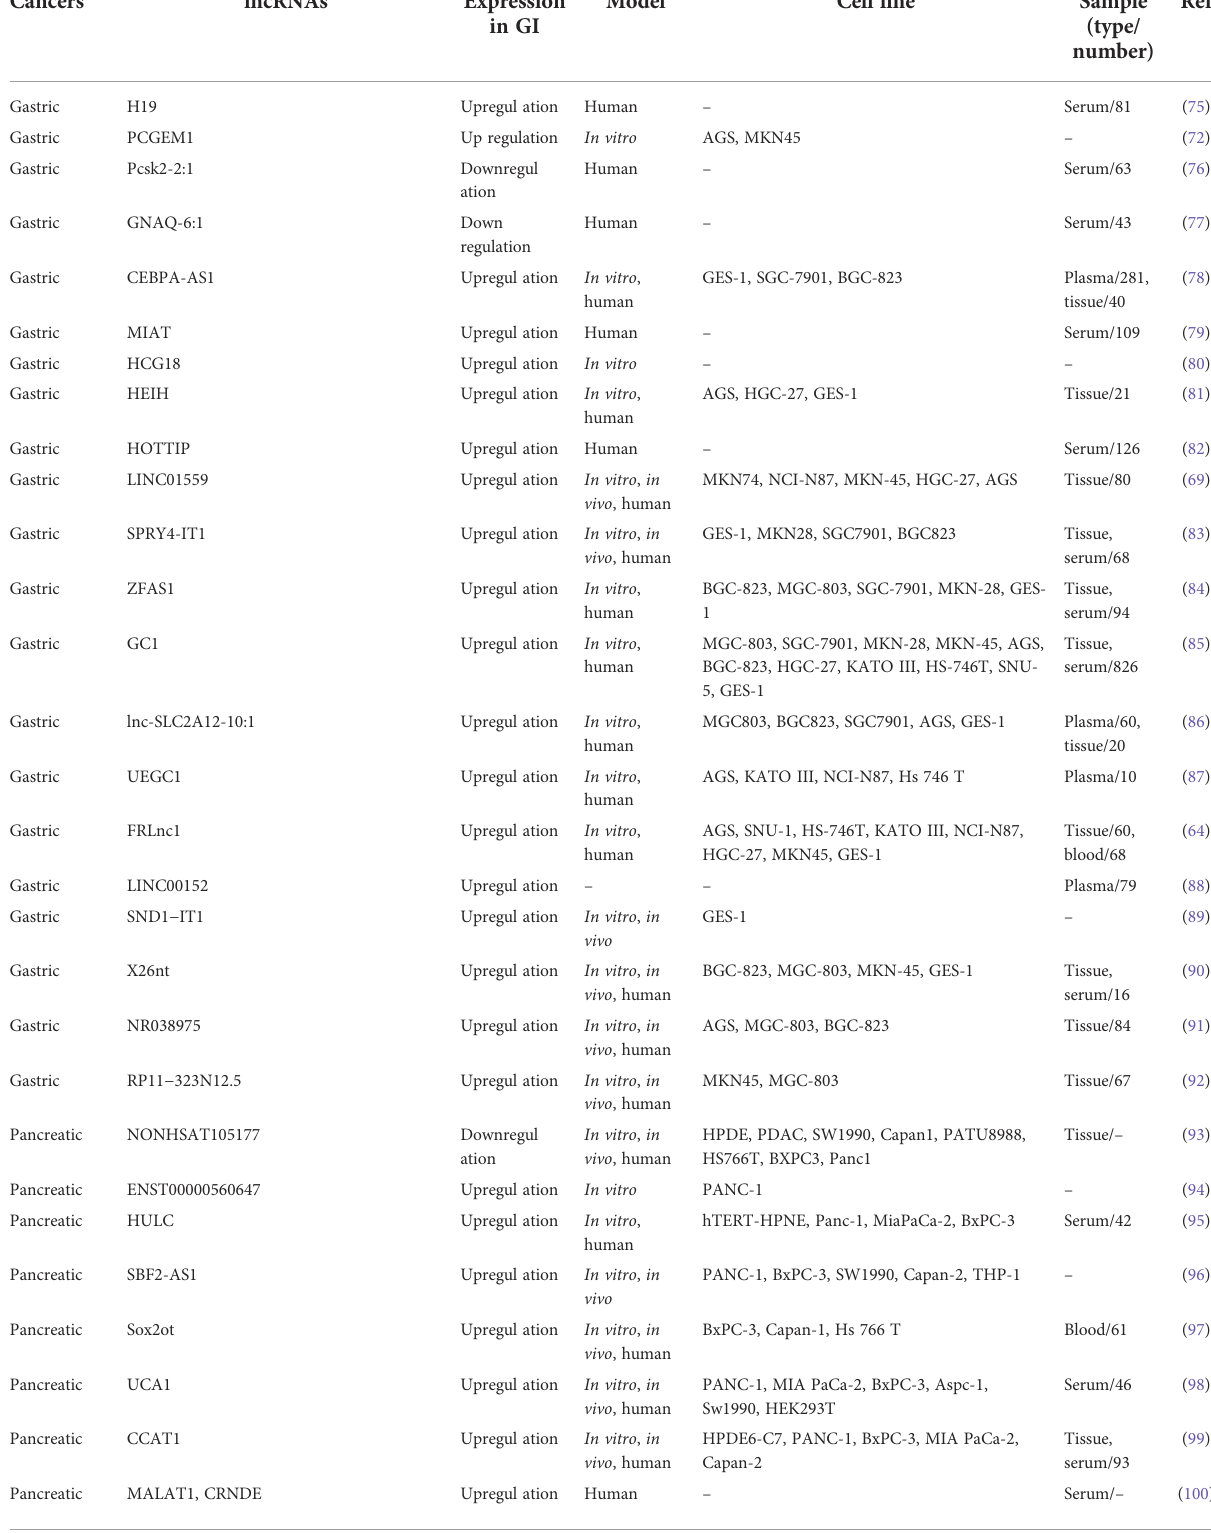
TABLE 1 Summary of the involvement of lncRNAs in different GI